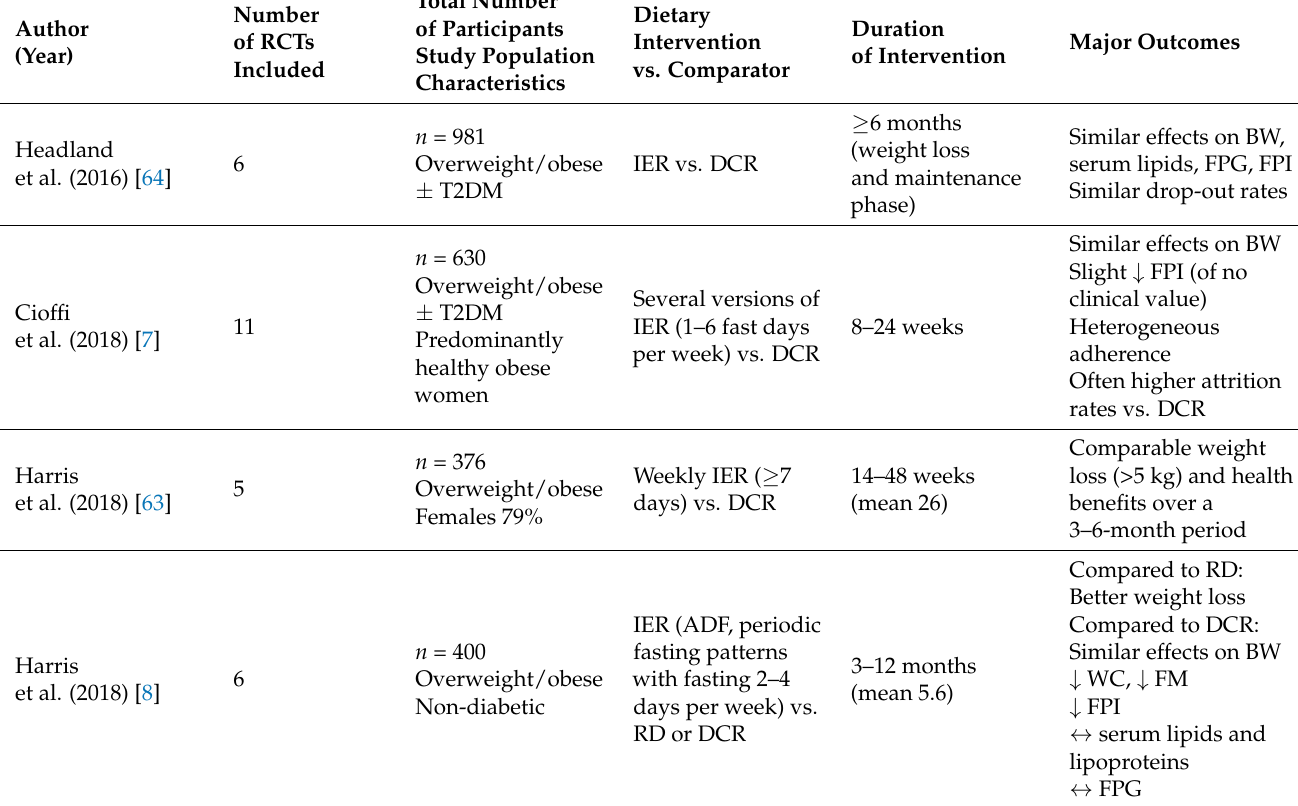
Table 2. A summary of the major systematic reviews and meta-analyses of RCTs in the field of intermittent fasting in overweight and obese